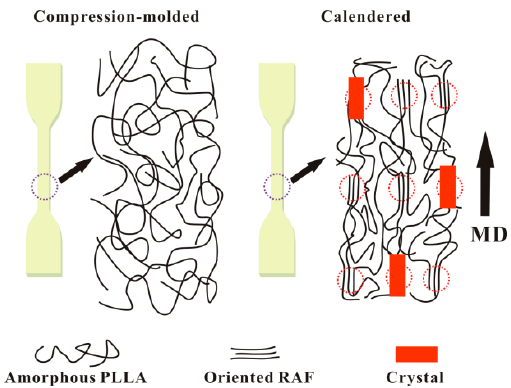
Figure 7. Schematic illustration of internal structures of neat PLLA samples prepared by compression-molding and compression-molding and calendering.